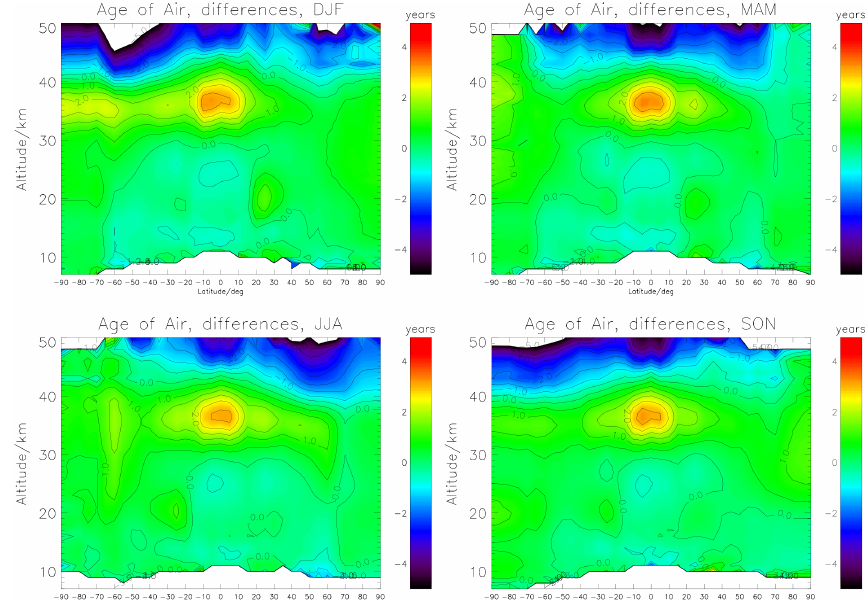
Figure 4. Differences of zonal seasonal mean distribution of mean age of stratospheric air to the previous data version averaged for the four